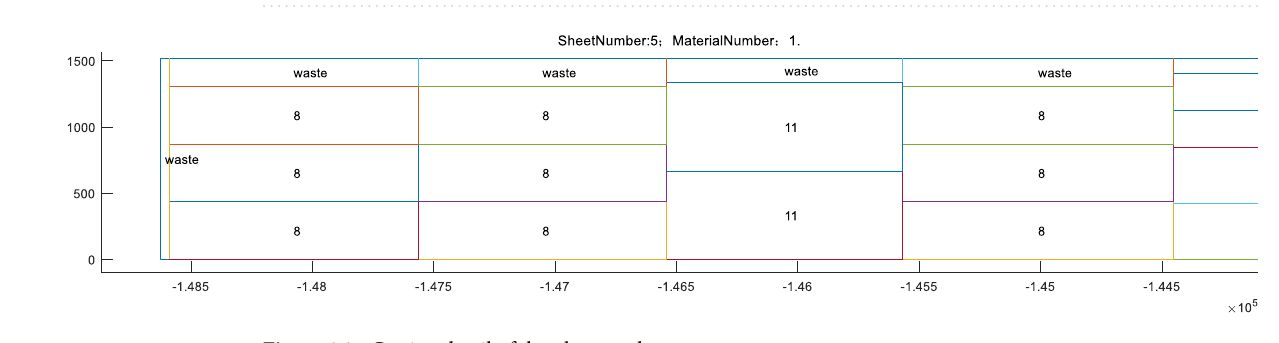
Figure 26. Cutting detail of the plate